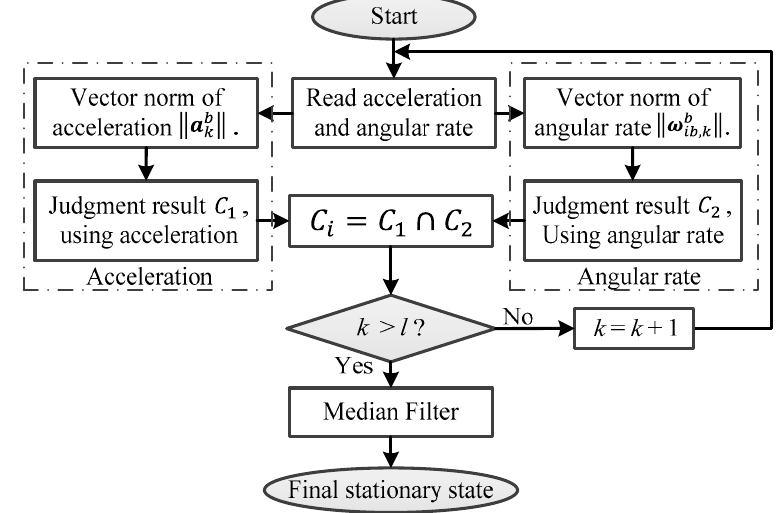
Figure 3. Flowchart for the judgment of the strap-down inertial navigation system (SINS) stationary state.